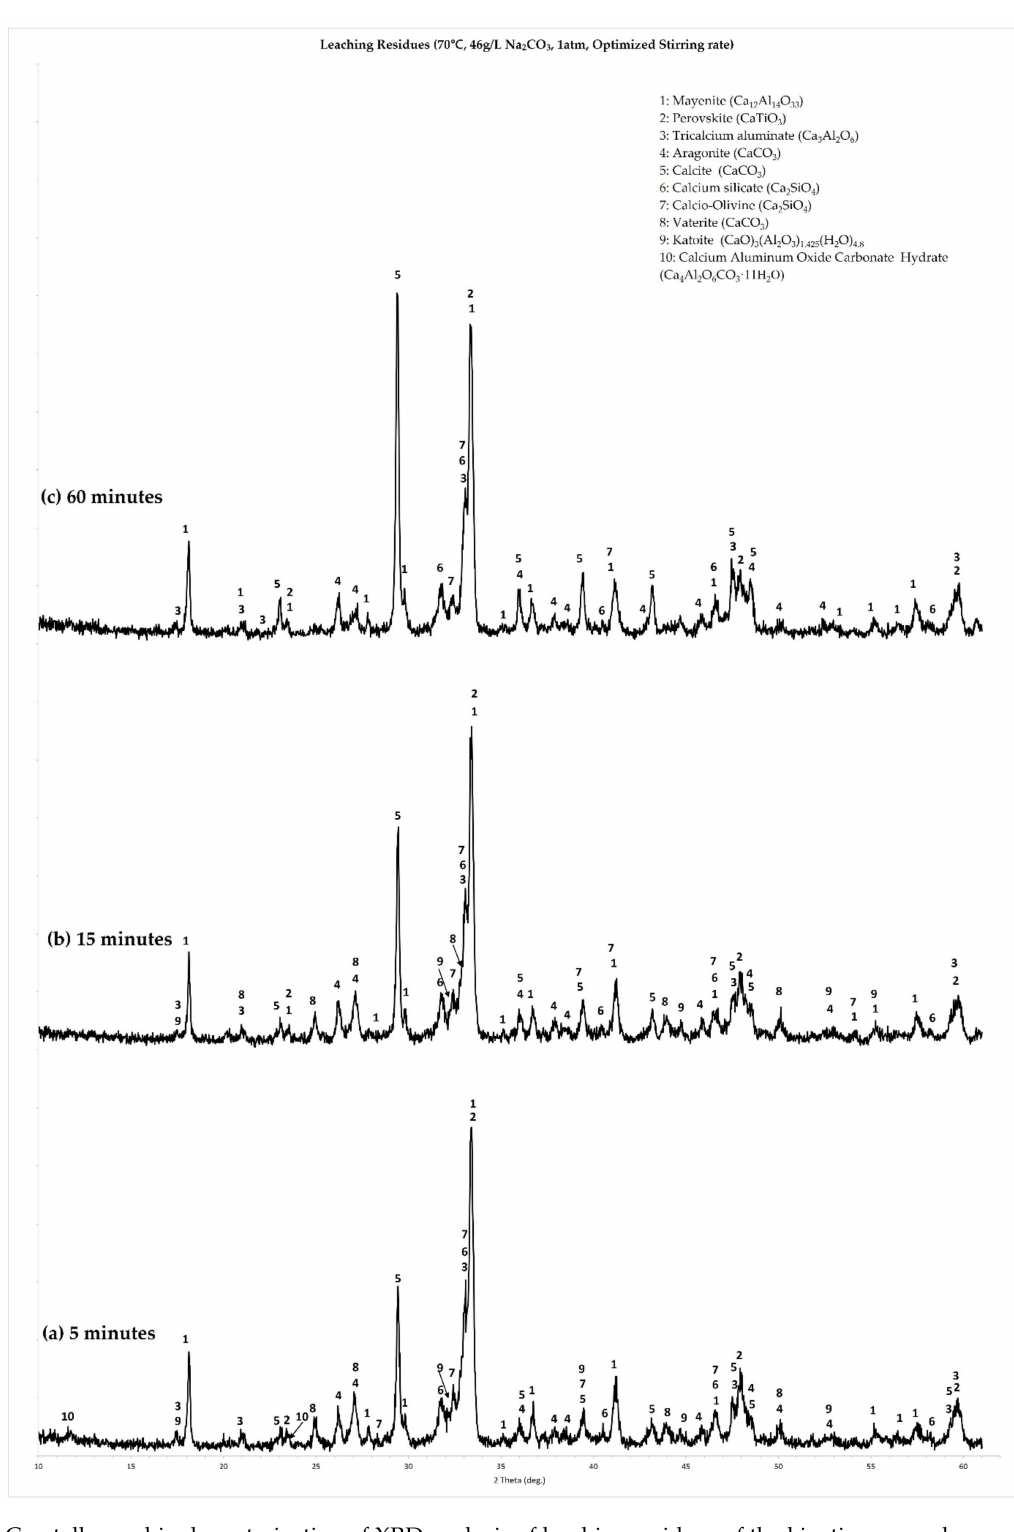
Figure 8. Crystallographic characterization of XRD analysis of leaching residues of the kinetic approach experiments at 70 ◦ C: ( a ) residue of 5 min leaching test, ( b ) residue of 15 min leaching test and ( c ) residue of 60 min leaching